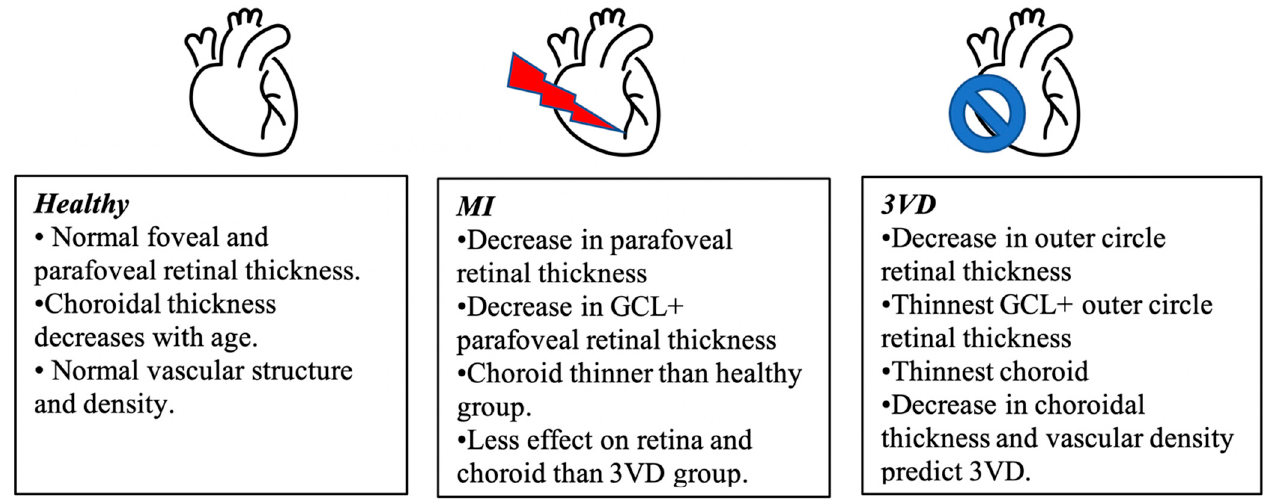
Figure 5. Main outcomes of the study. Table 4. OCT and OCTA results of the studies investigating coronary heart disease.